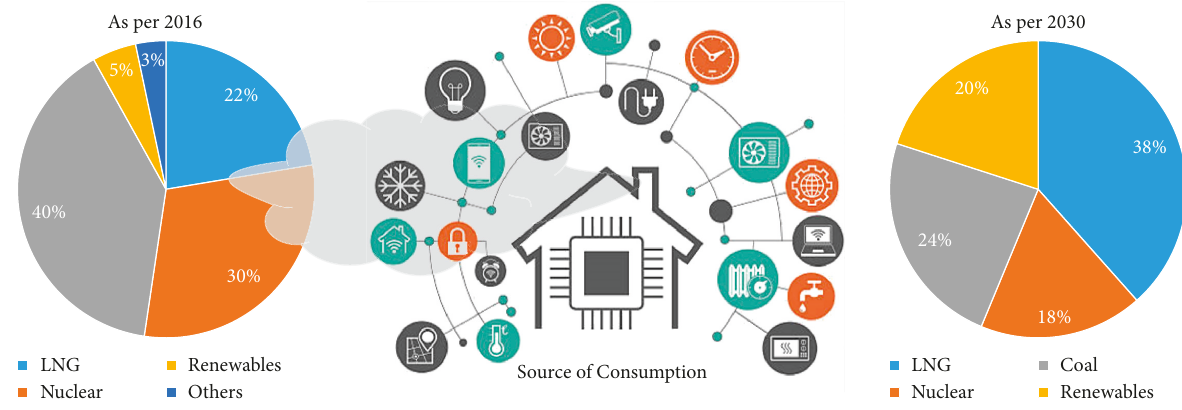
Figure 1: Statistics of power energy generation [6] as of 2016 and 2030. Also, different sources of power energy consumption are